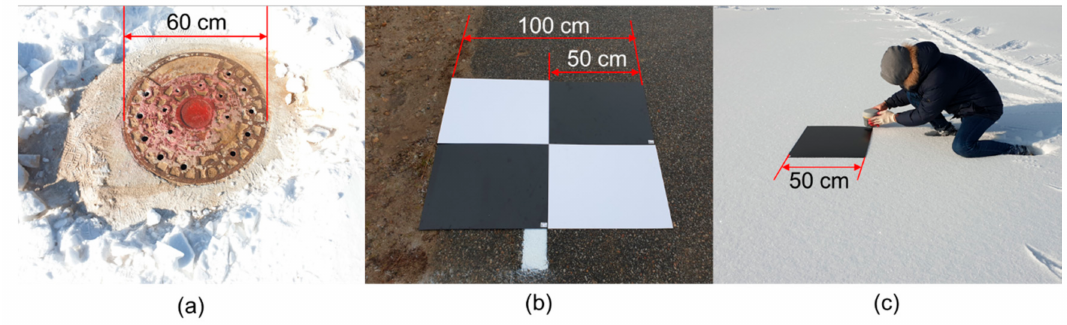
Figure 3. Various GCPs used in this study: ( a ) A manhole; ( b ) Lines on the road; ( c ) A black planar object on the snow surface. These photographs were taken on the 4